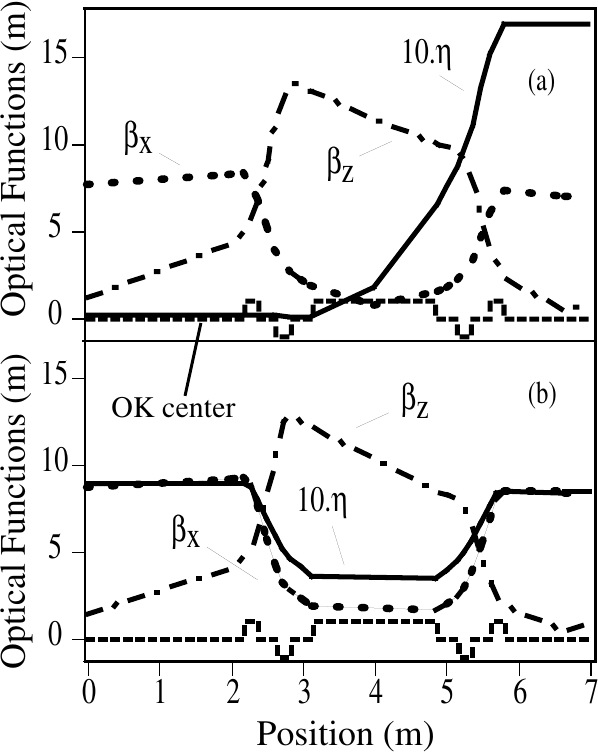
FIG. 1. Optical functions of UVSOR-II at 600 MeV: (a) ach- romatic optics, (b) chromatic optics. Dashed line: position of the